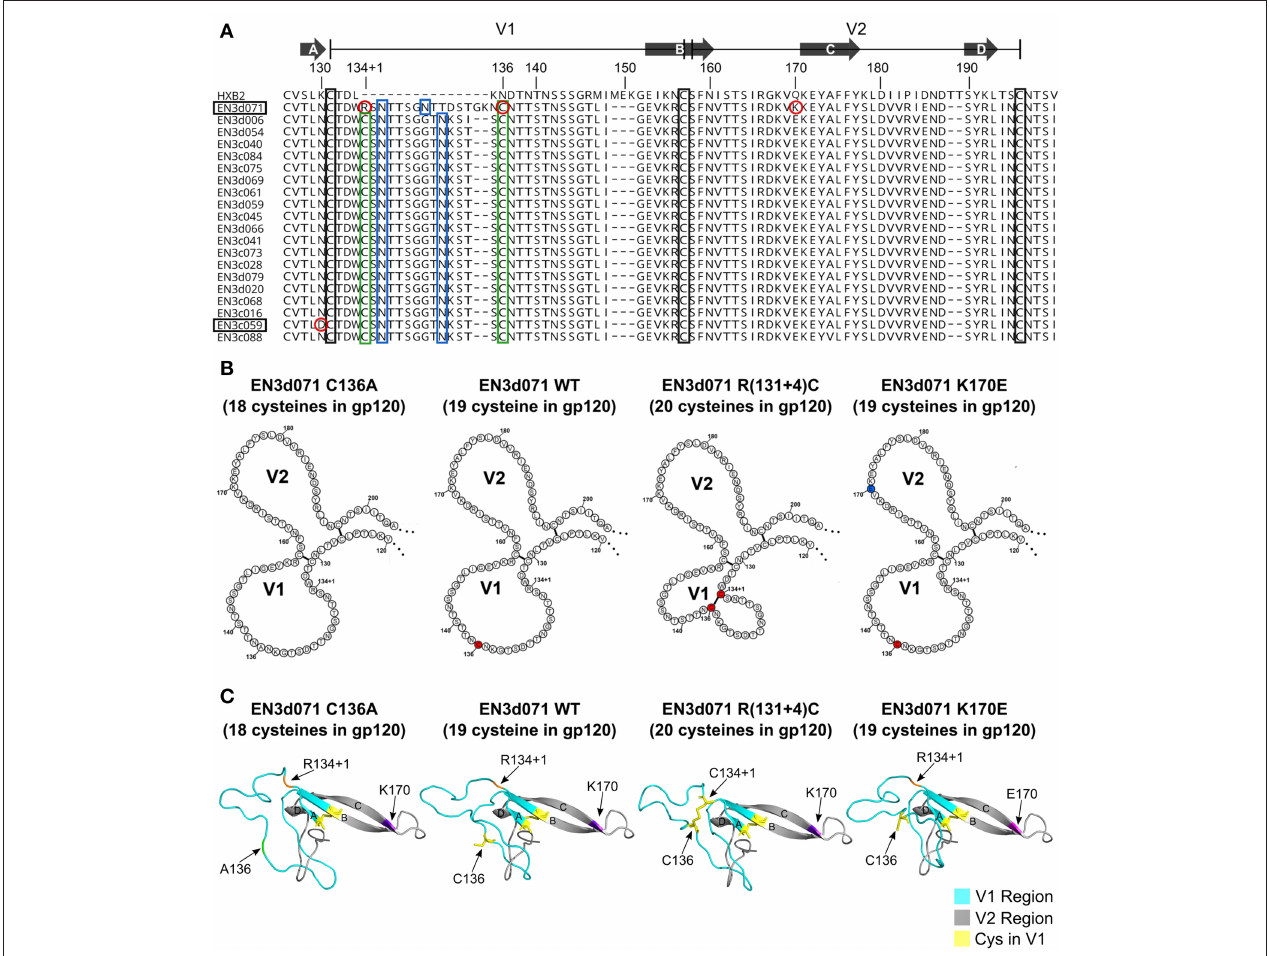
FIGURE 2 | V1/V2 regions of proviral sequences isolated from an elite suppressor (EN3). (A) Alignment of functional proviral sequences isolated from an elite suppressor (EN3). V1 region is defined as amino acids 131–157 and V2 region is defined as amino acids 158–196 using sequence numbering relative to HXB2 reference standard. Arrows above the alignment show the location of four beta strands described in McLellan et al. ( 13). Black rectangles show the location of canonical cysteines in the V1/V2 region. Green rectangles show aberrant cysteines in functional sequences isolated from EN3. Blue rectangles show potential N-linked glycosylation sites that are part of the 13 or 15 amino acid insertion in V1. Residues circled in red were targeted in mutagenesis experiments. (B) Primary structure of EN3d071 wild type (WT) and mutants. Single point mutations of EN3d07 WT were introduced to create three different mutants of Env (EN3d071 C136A with no extra cysteines in V1, EN3d071 R(134 + 1)C with two extra cysteines in V1, and K170E with one extra cysteine in V1). Non-canonical cysteines are shown in red. K170E mutation is shown in blue. (C) Homology models of gp120s EN3d071 wild type (WT) and mutants. Homology models of EN3d071 C136A (18 cysteines), EN3d071 WT (19 cysteines), EN3d071 R(134 + 1)C (20 cysteines), and EN3d071 K170E (19 cysteines) were built using Modeler v9.21 with 5fykG template. V1 regions are shown in cyan. V2 regions are shown in gray. Cysteines located in the V1 region are shown in yellow. Polymorphisms are labeled with A136 shown in green, R(134 + 1) shown in orange, K170 shown in purple, and E170 shown in